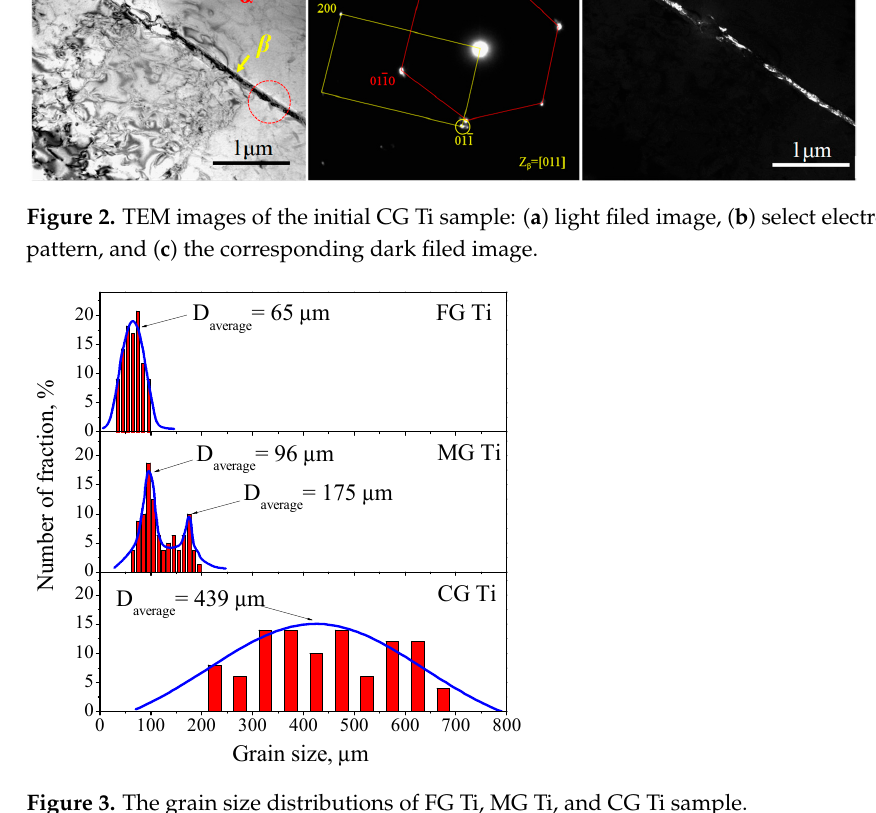
Figure 3. The grain size distributions of FG Ti, MG Ti, and CG Ti sample.